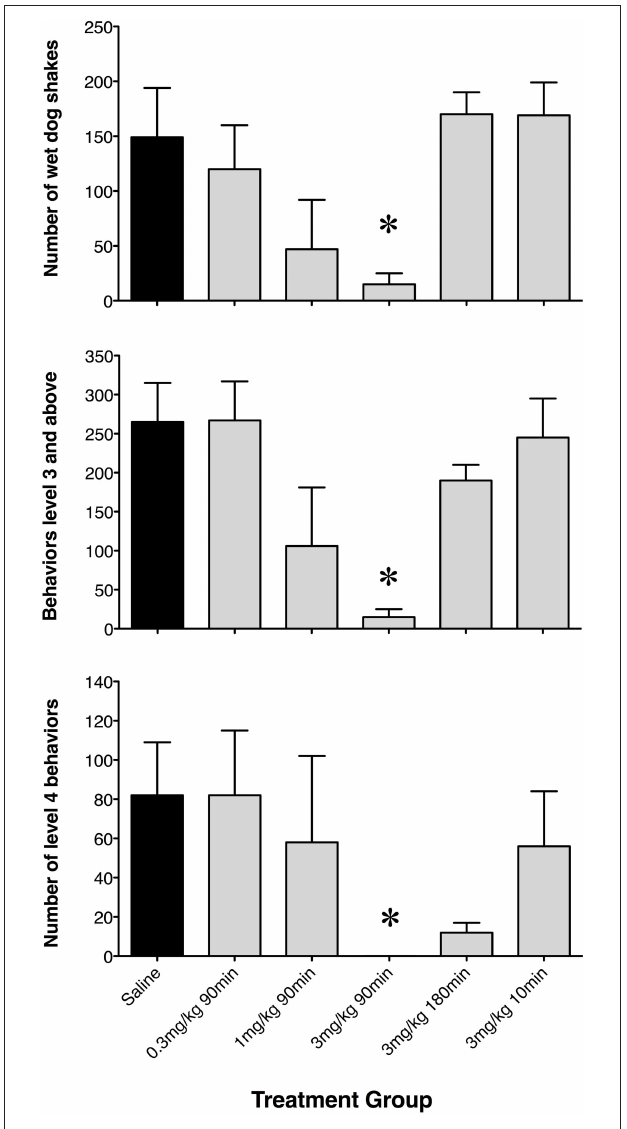
FIGurE 2 | Net occurrence of wet dog shakes, level 3 and level 4 seizure behaviors exhibited following saline or low-dose GYKI 52466 preconditioning. Histograms show mean ± SEM number of discrete events during the 2-h seizure induction period. Labels along the x axis indicate preconditioning paradigm.* p < 0.05 vs.